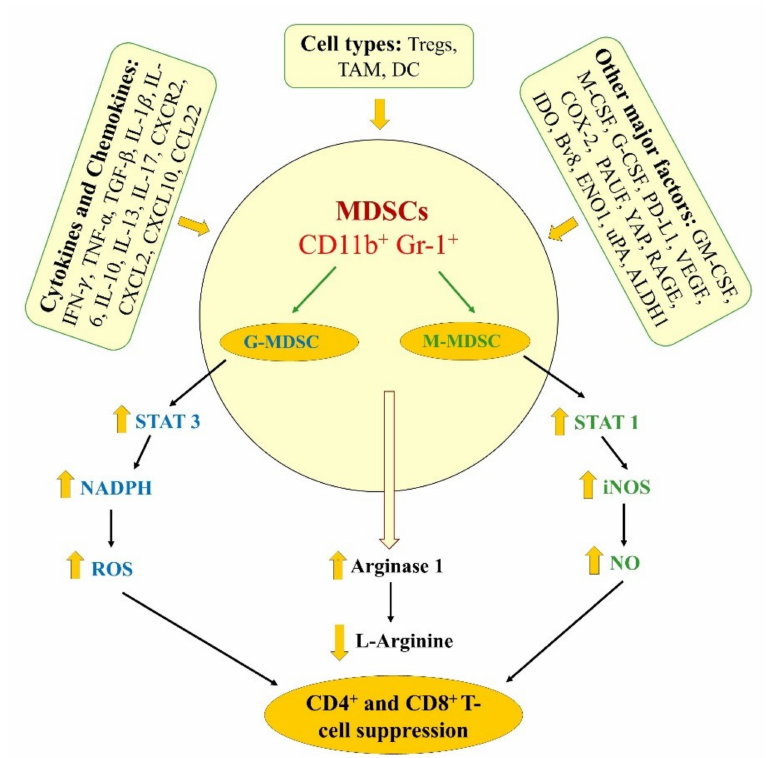
Figure 2. Mechanisms involve in mediating the immunosuppressive function of MDSC, which include various cytokines and chemokines, immune cells and major factors, implicated in inhibiting T-cell responses as it related to